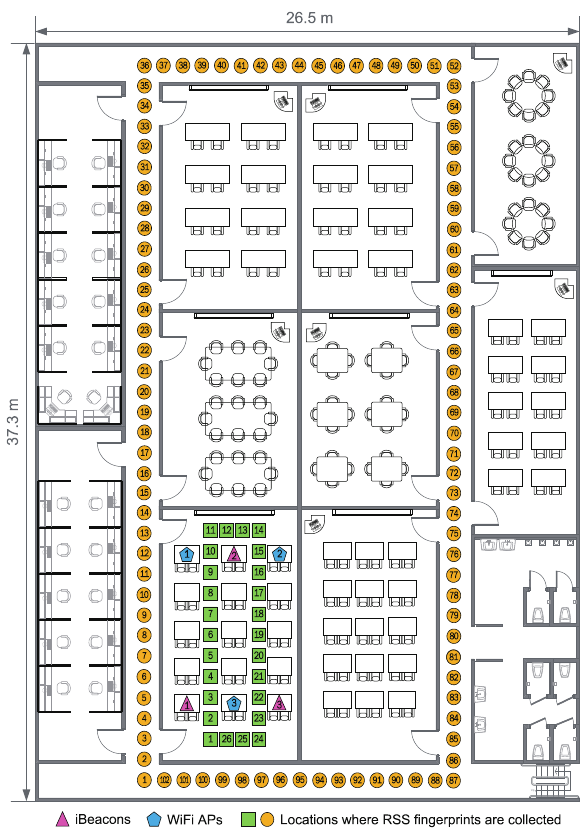
Figure 7. Floor plan of the test site where the experiments were carried out. RSS information is recorded in the hallways and inside the lecture